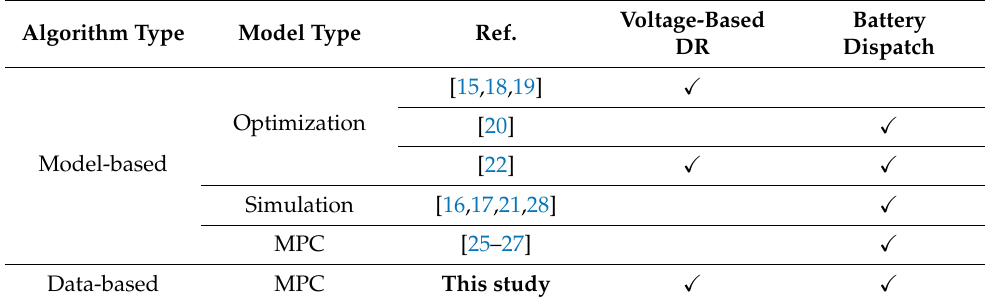
Table 1. Review of some relevant studies about DC microgrid optimization